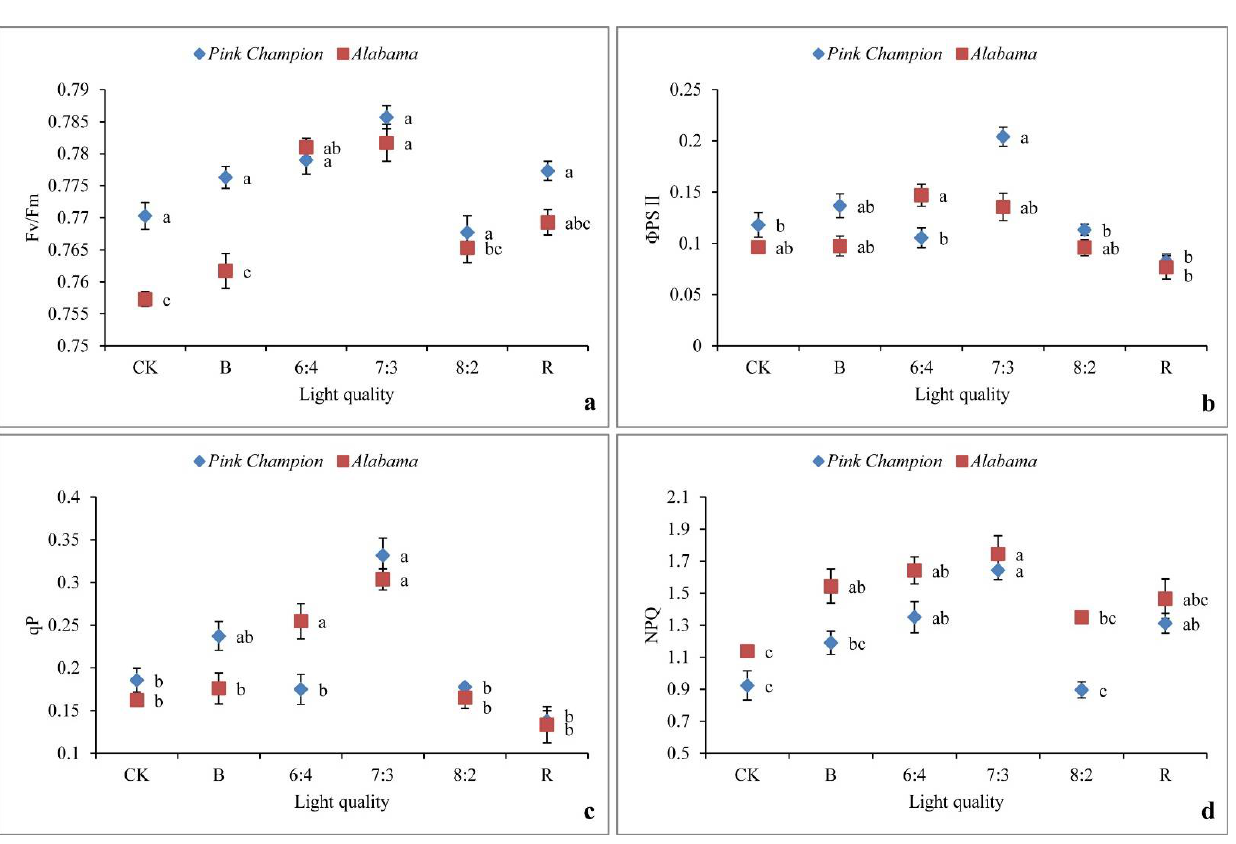
Figure 3. Effects of different light qualities on leaf chlorophyll content of Anthurium ‘Pink Champion, Alabama’ (( a ) Chl a, ( b ) Chl b, ( c ) Carotenoid, ( d ) Chl a + b, ( e ) Chl a/b.). The statistical analysis has been carried out separately for each cultivar. Vertical bars indicate standard error ( n = 5). Different letters represent a significant difference at p < 0.05 among treatments by the Duncan’s multiple range test.